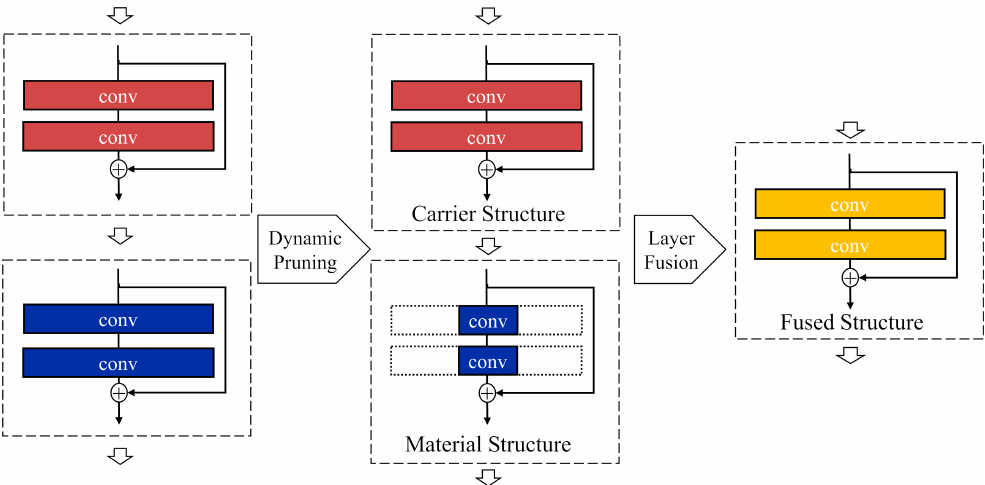
Figure 1. A diagram about the flow of proposed architecture-improvement strategy. The part enclosed by the dotted line indicates the compressed